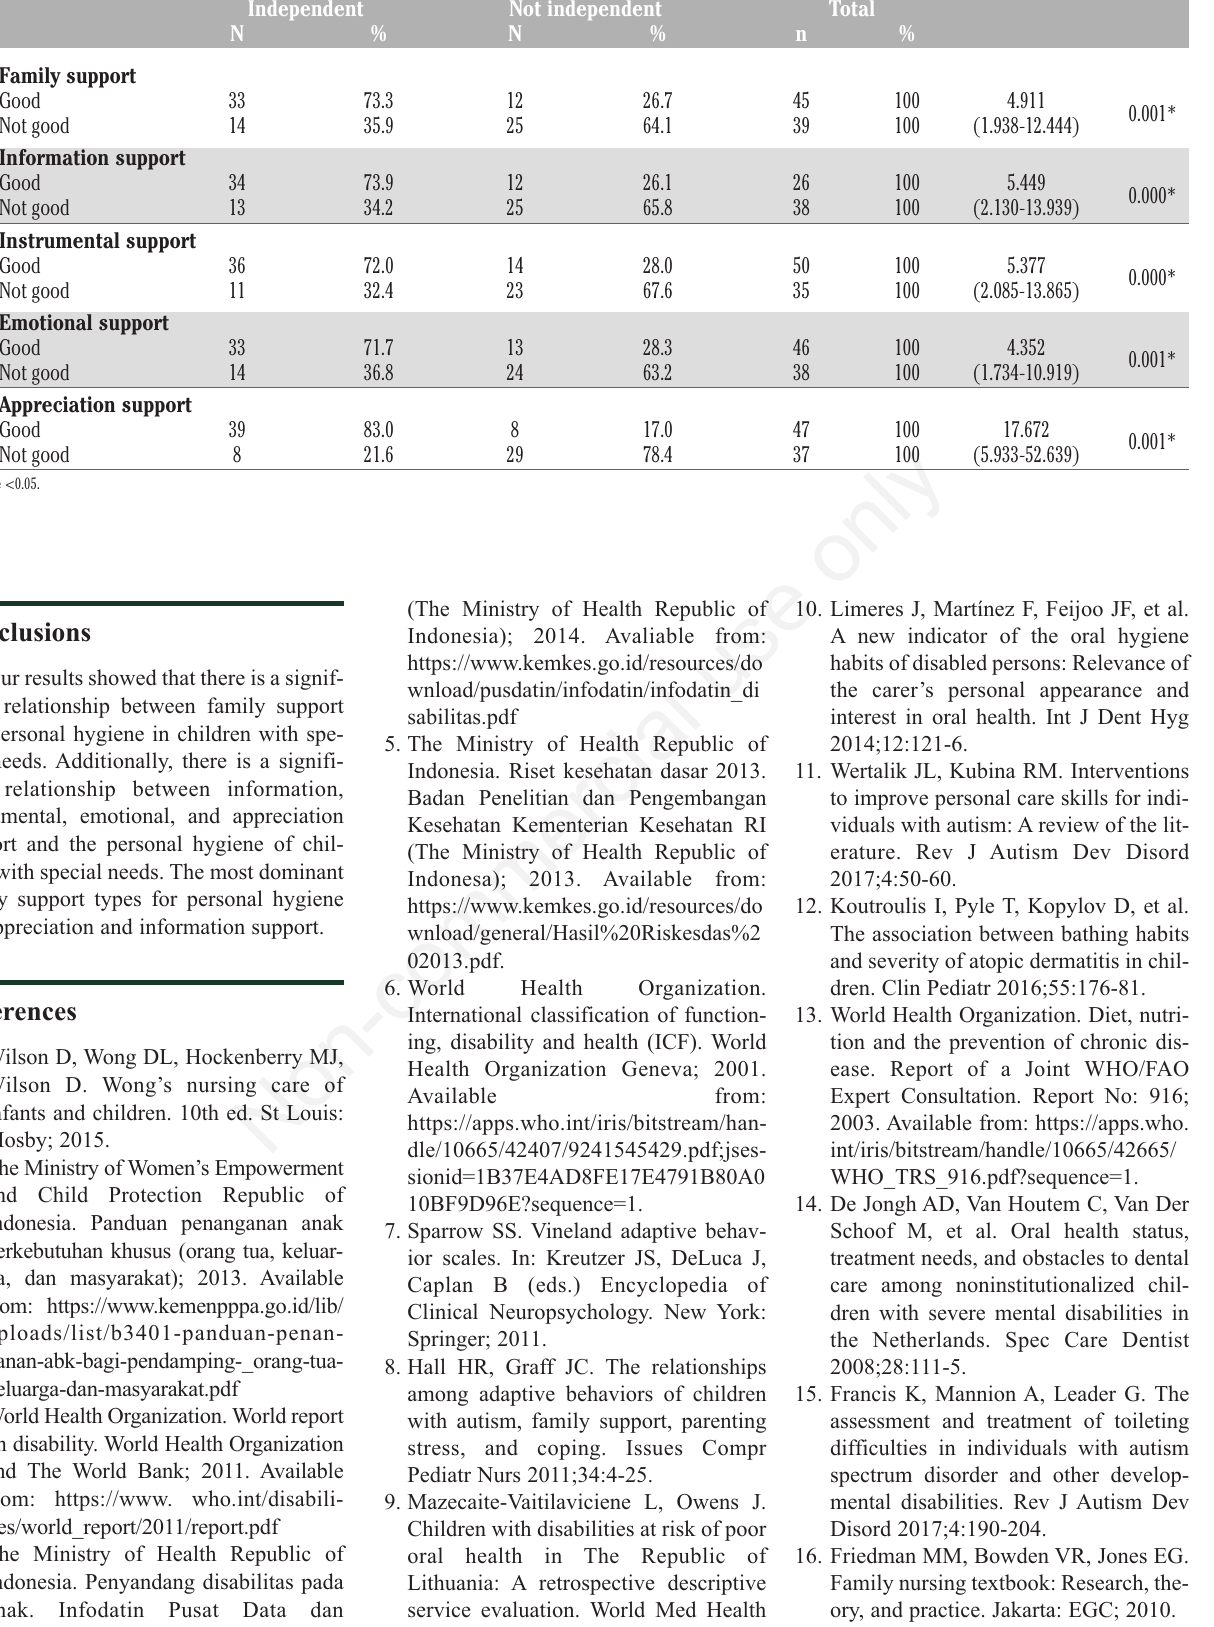
Table 3. Distribution of the relationship between family support and children with the ability to maintain personal hygiene in Bogor (n=84). No. Family support